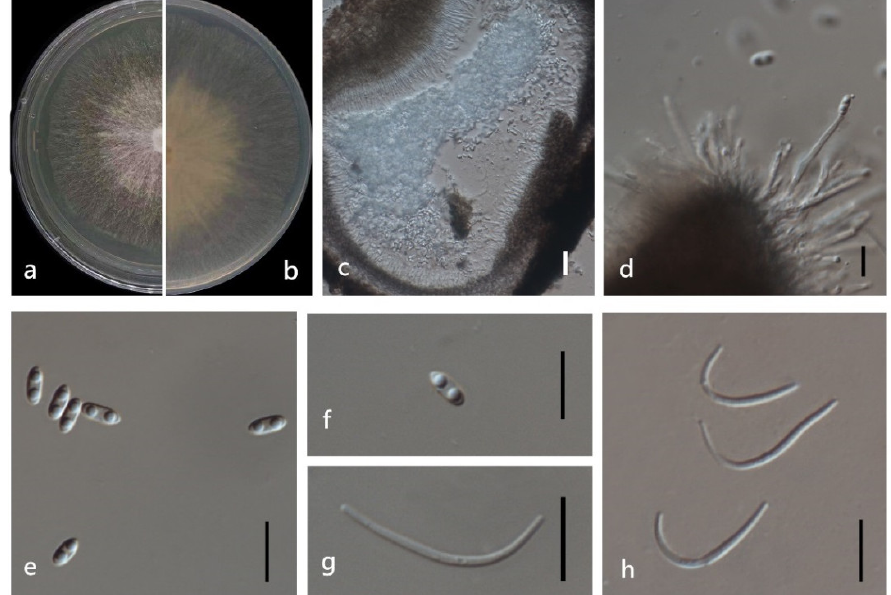
Figure 9. Diaporthe megabiguttulata (ZHKUCC 22-0067) ( a ) upper view of colonies on PDA; ( b ) Re- verse view of colonies on PDA; ( c ) Horizontal section through a pycnidia; ( d ) Conidiogenous cells; ( e , f ) Alpha conidia; ( g , h ) Beta conidia. Scale bars: ( c ) =100 µm; ( d – h ) =10